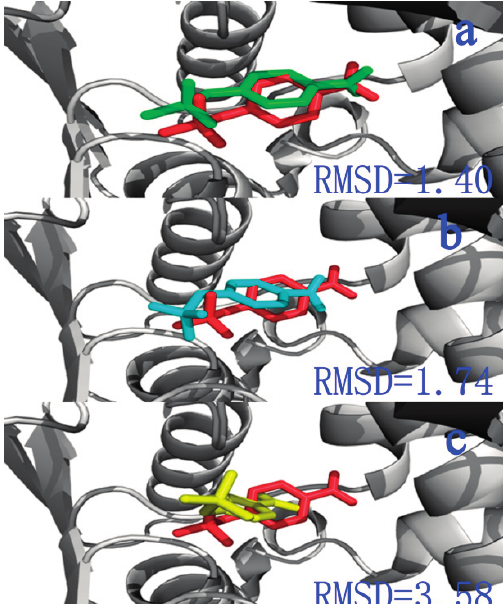
Figure 2. ( a ) The compartment between the docked ligand (green) and the reference for the crystal structure (red) located in the active site. Calculated by Autodock 4.2; ( b ) The compartment between the docked ligand (light blue) and the reference for the crystal structure (red) located in the active site. Calculated by Autodock vina; and ( c ) The compartment between the docked ligand (yellow) and the reference for the crystal structure (red) located in the active site. Calculated by